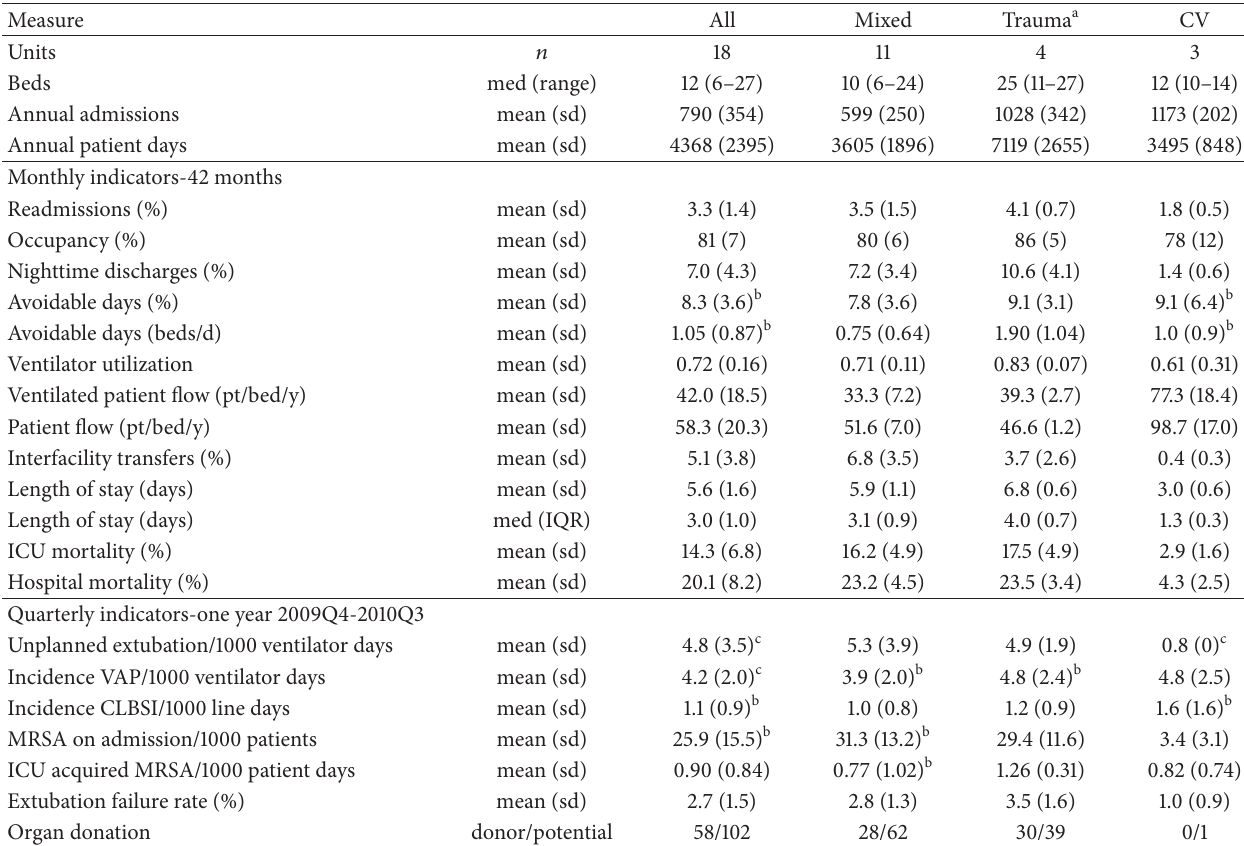
Table 2: Unit characteristics and average performance.